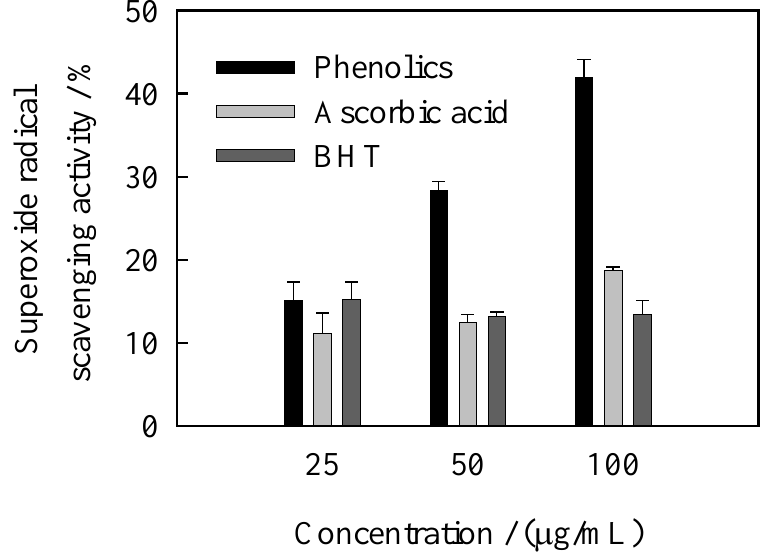
Figure 5. Superoxide radical scavenging activity of phenolics from litchi pericarp